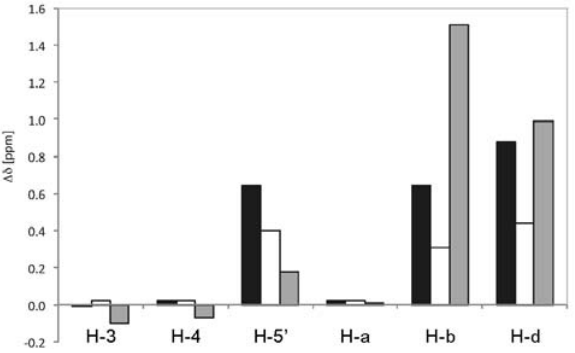
Figure 3. 1 H NMR chemical shift changes, Δδ = δ (in the presence of anions) – δ (in the absence of anions), induced by addition of one equivalent of chloride ( (cid:2) ), bromide ( (cid:3) ) and acetate ( (cid:2) ) anions to receptor 1 .